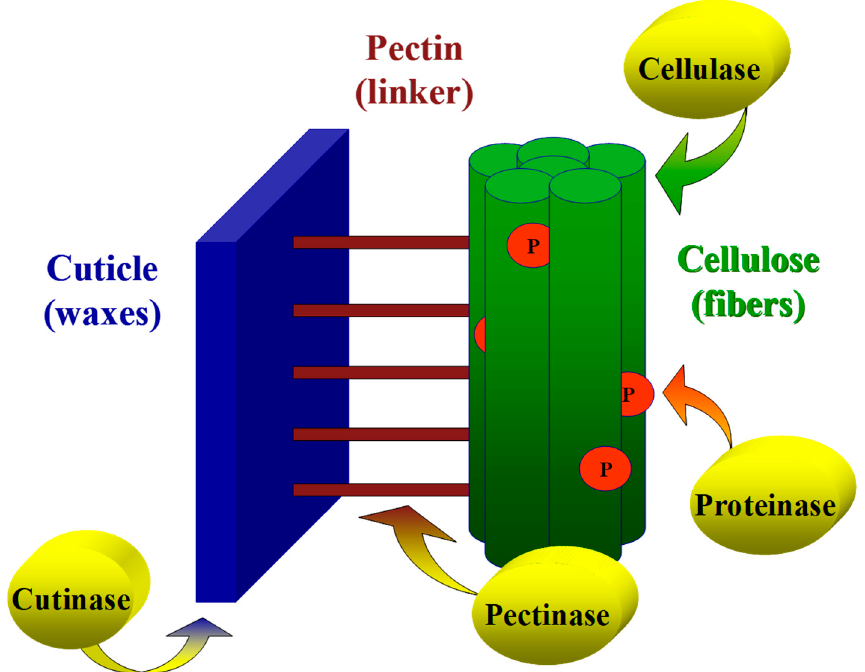
Figure 9. A model demonstrating the action mechanism of cutinase and pectinase on the cotton fiber cell wall. The integrated effect of cutinase and pectinase accelerates the cuticle layer’s degradation. This initiative enzyme activity enables the subsequent cellulase and proteinase attack on the plant’s cell walls, cellulose and proteins.